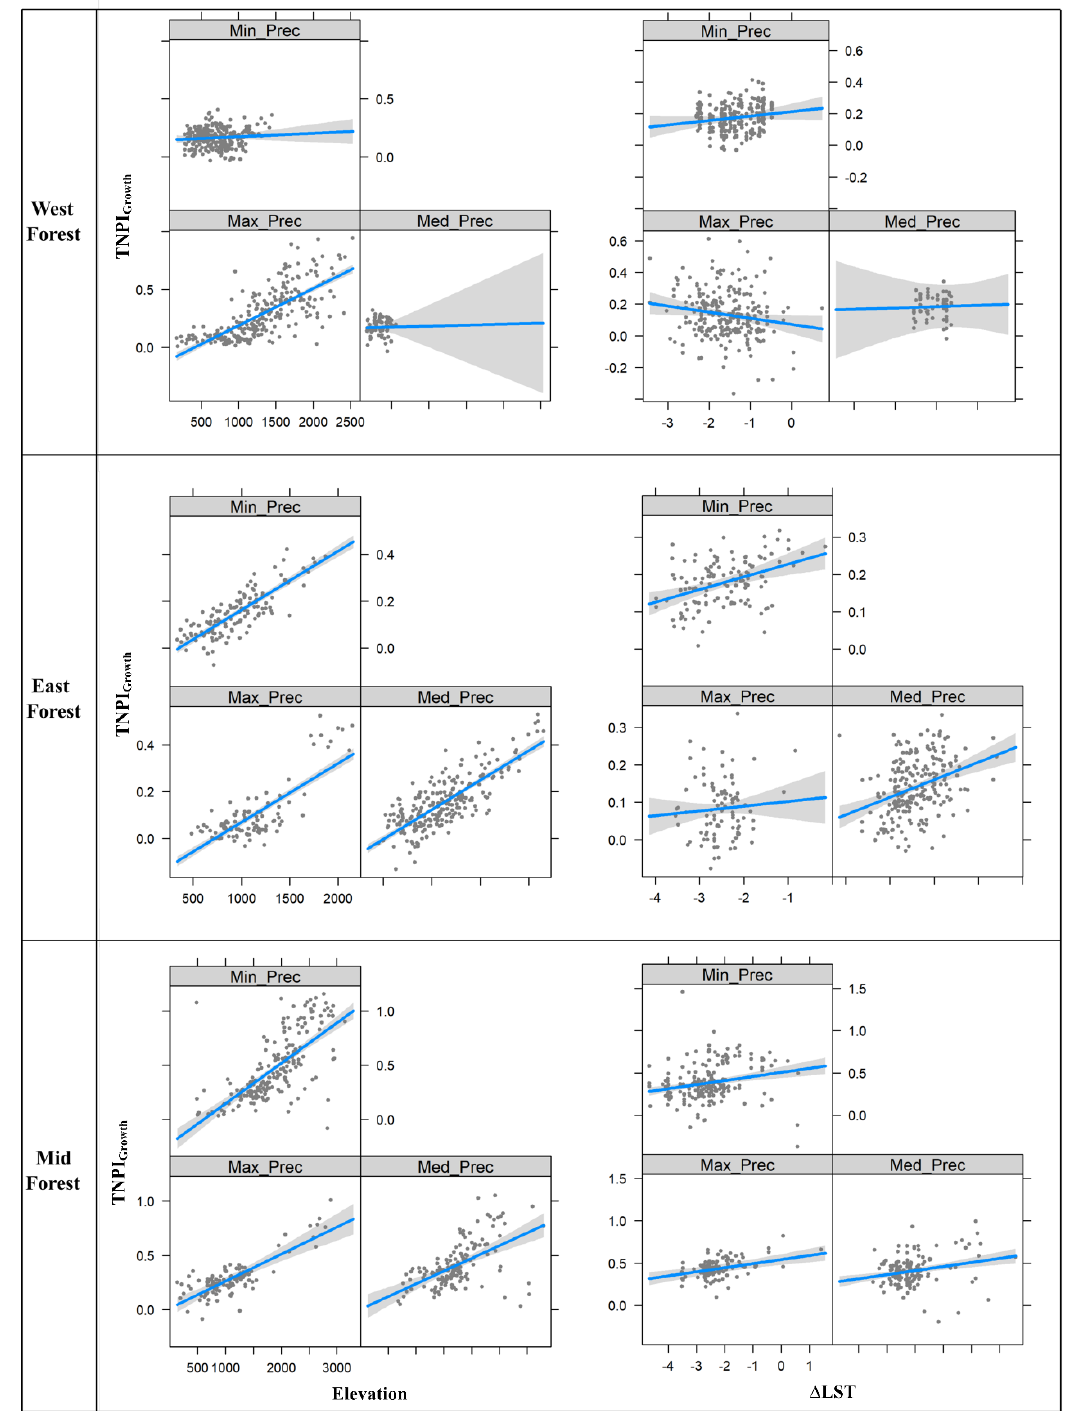
Figure 7. Cross-sectional plots of three forest zones for Sentinel-2-derived TNPI Growth models with an interaction between elevation and precipitation, and elevation and LST. The first panel depicts the western forests, the second panel depicts the eastern forests, and the last panel shows the middle forest zone as described in Section 2.2.9.